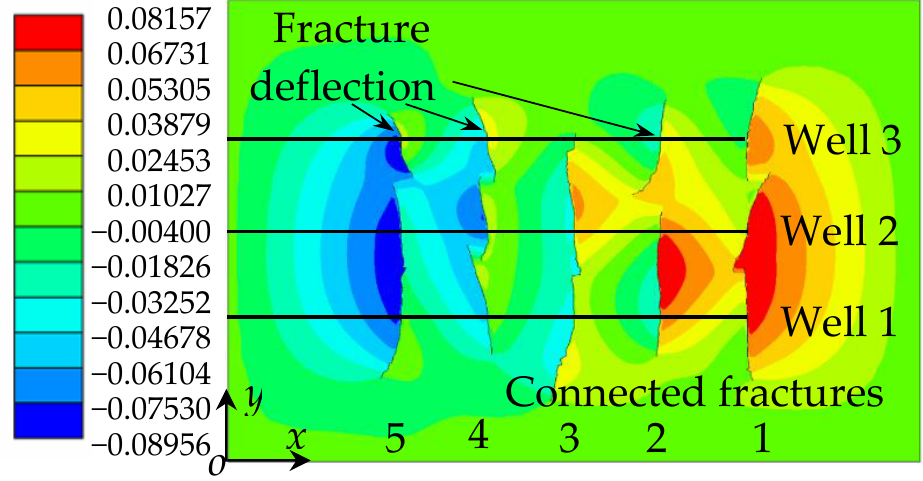
Figure 9. Final fracture network morphology and deformation in multi-well fracturing; b = 75 m.